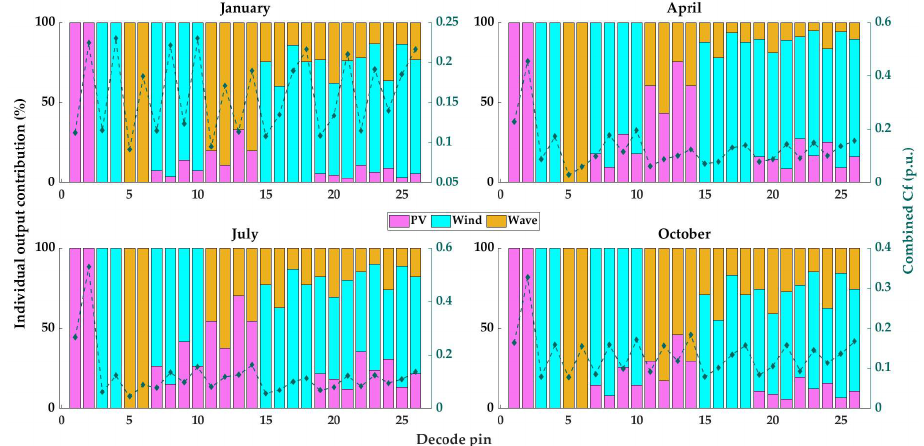
Figure 11. Seasonal comparison of the contribution of each source to the capacity factor .